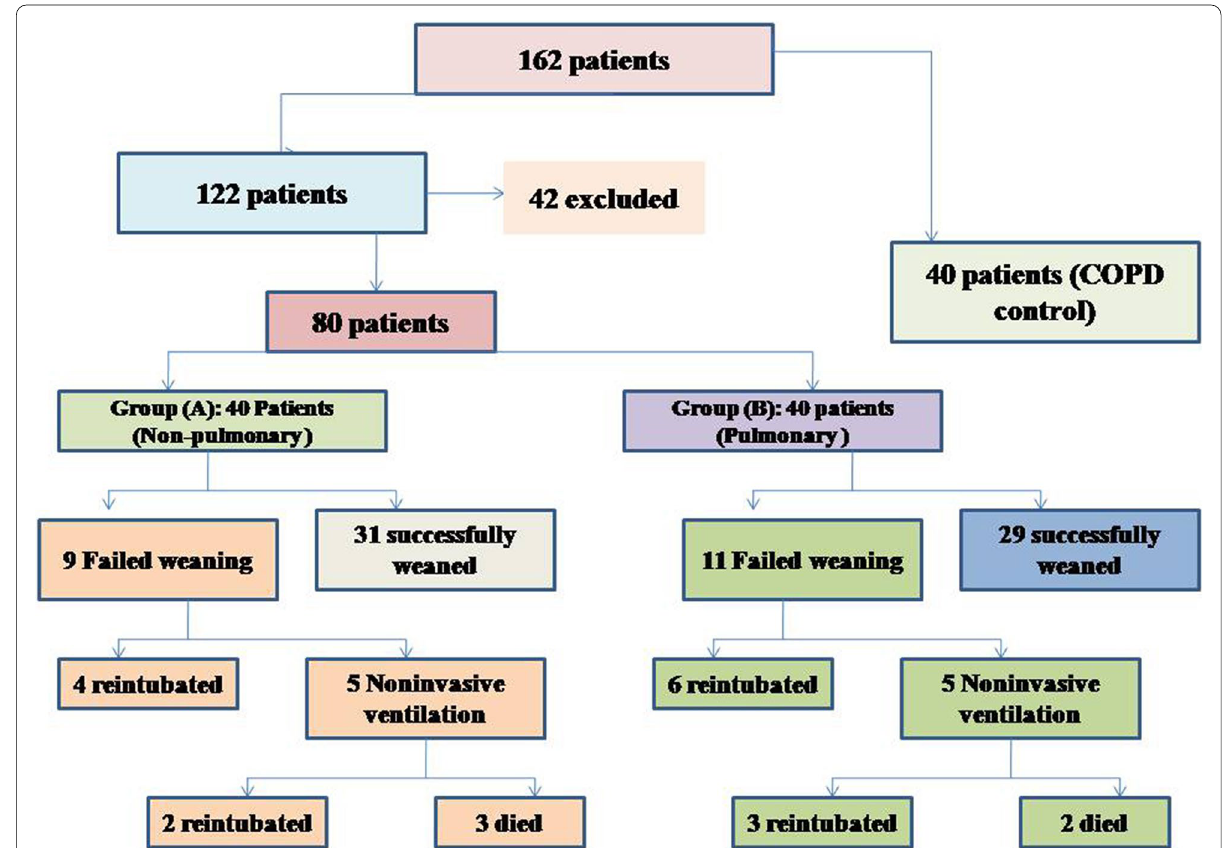
Fig. 2 Flow chart showing criteria of patients’ selection and follow-up through the